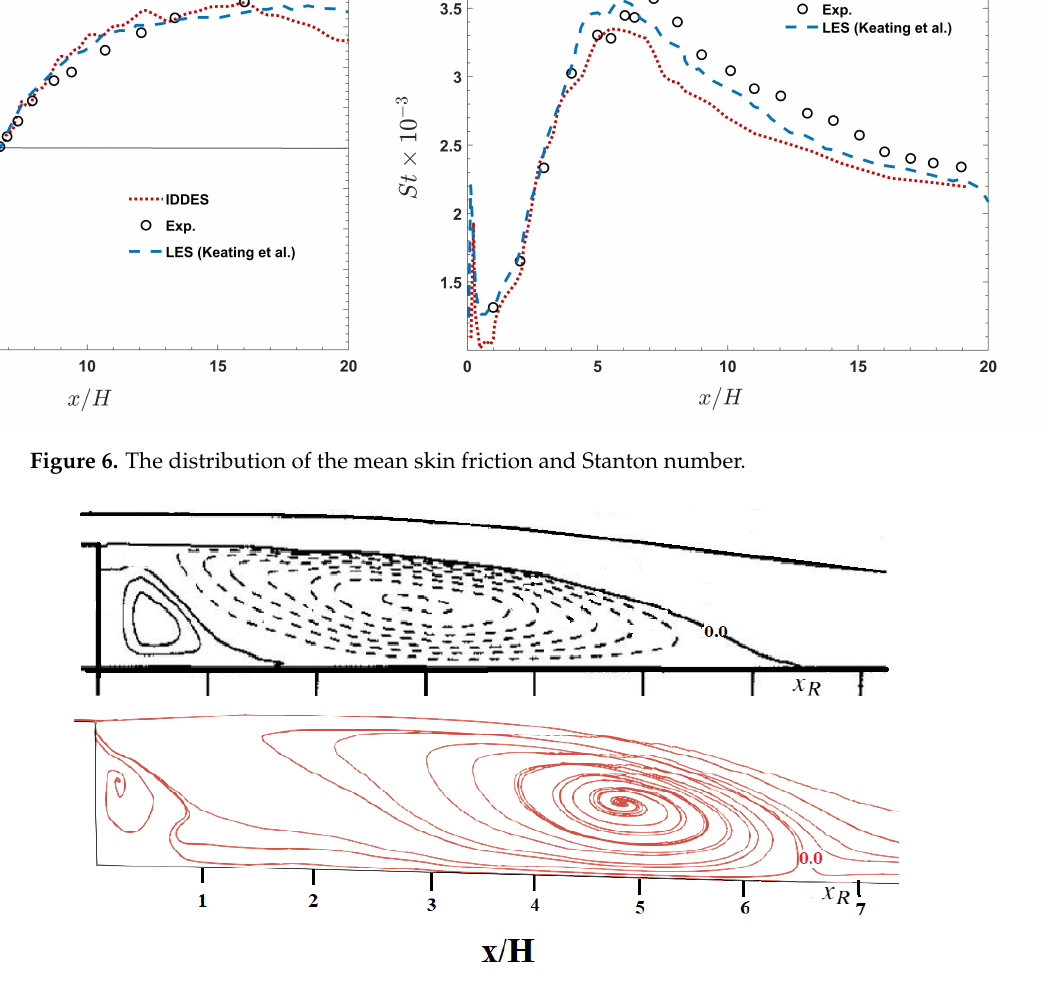
Figure 7. Mean streamlines obtained experimentally, recreated from [29] ( upper ) and applying the IDDES model ( lower ) for the isothermal wall. (Upper figure reproduced with permission from [16], published by American Society of Mechanical Engineers